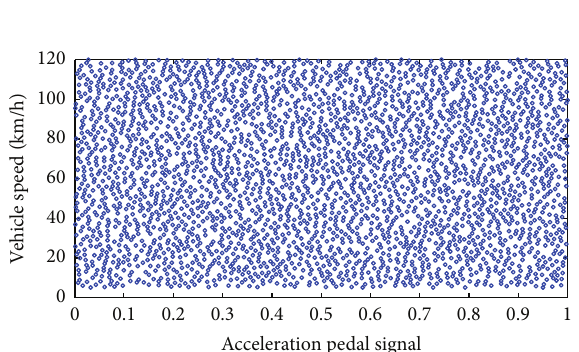
Figure 8: The sampling points in the design space.